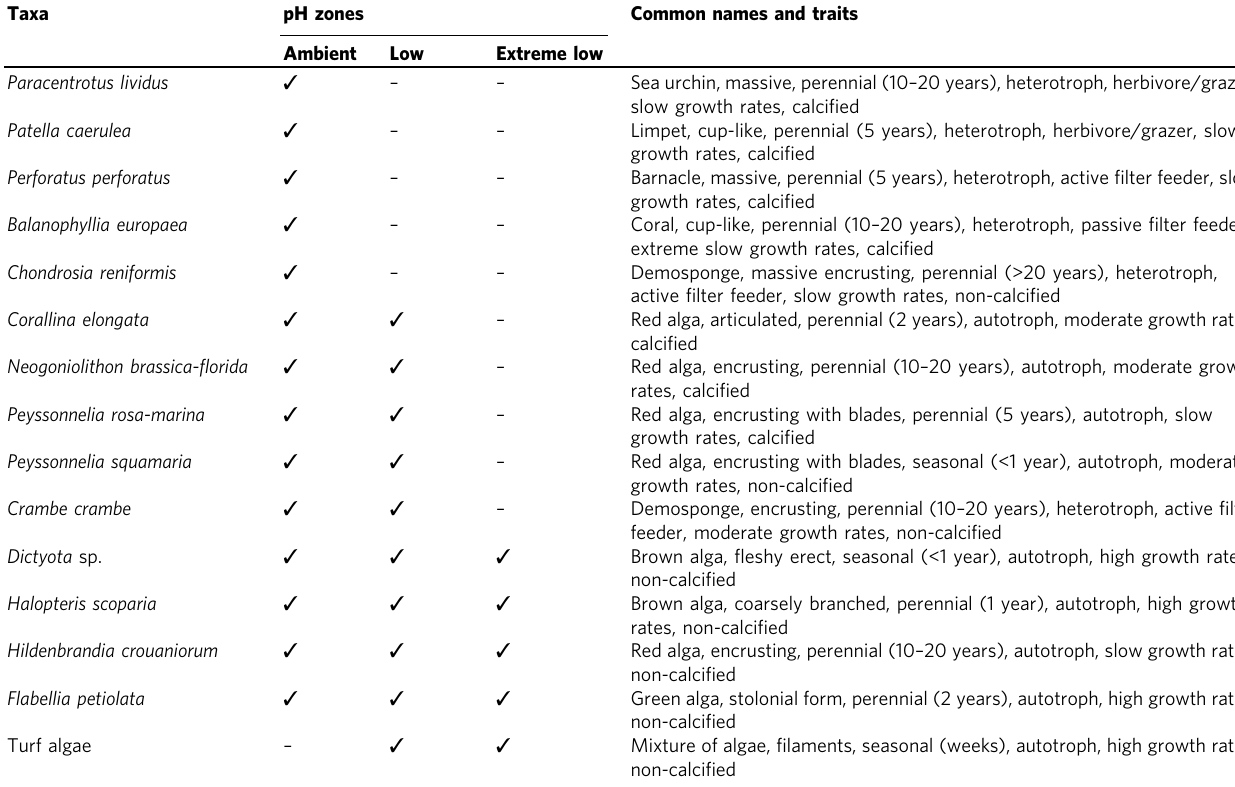
Table 1 Summary of selected species and their functional traits found among the pH zones